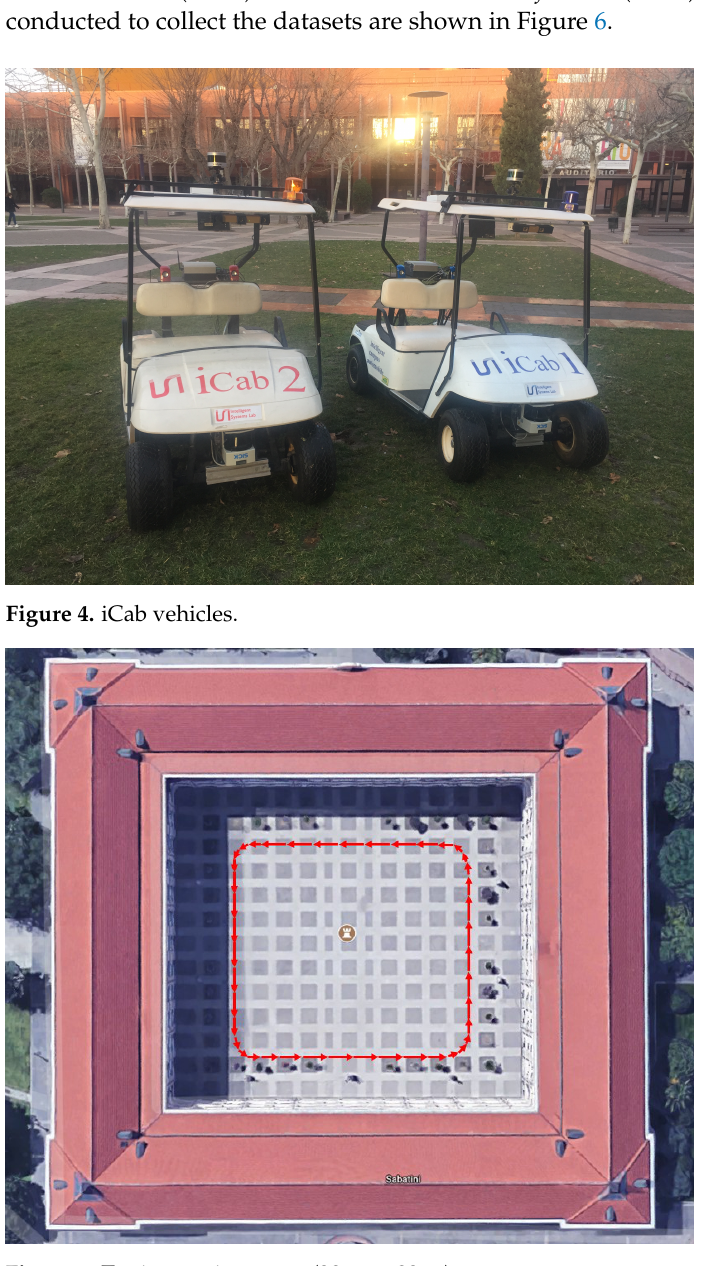
Figure 5. Testing environment (38 m × 33